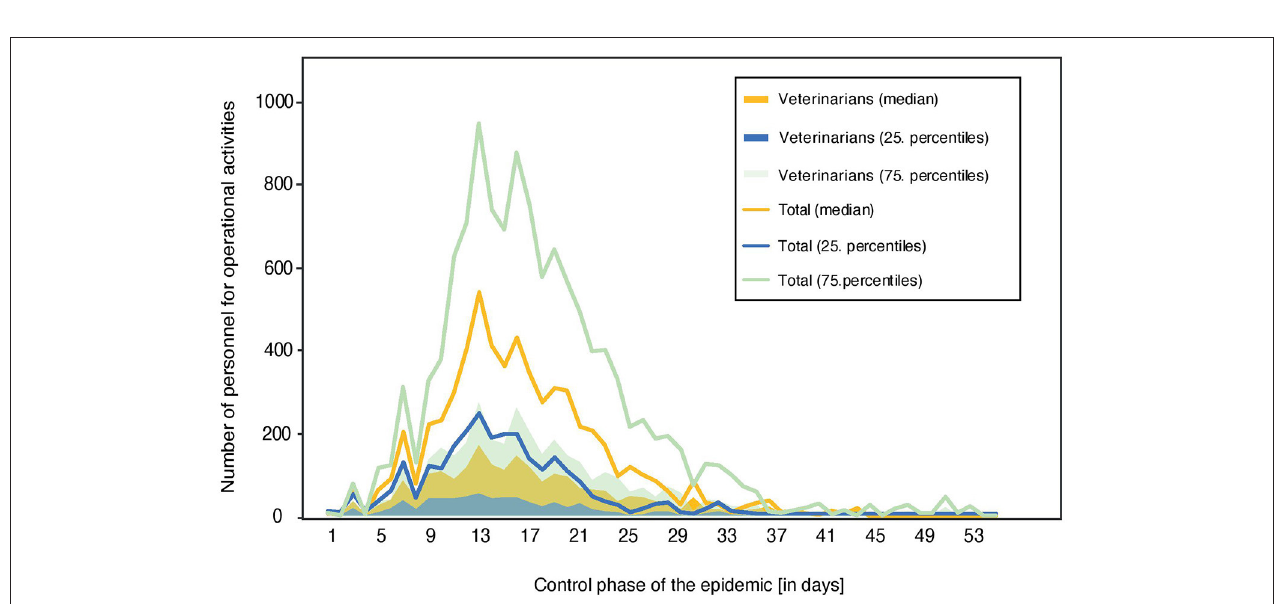
FIGURE 1 | Number of conducted surveillance visits and number of new detected infected herds (2 nd axis) in the daily course of the control phase under reference control strategy of an FMD outbreak in Austria.